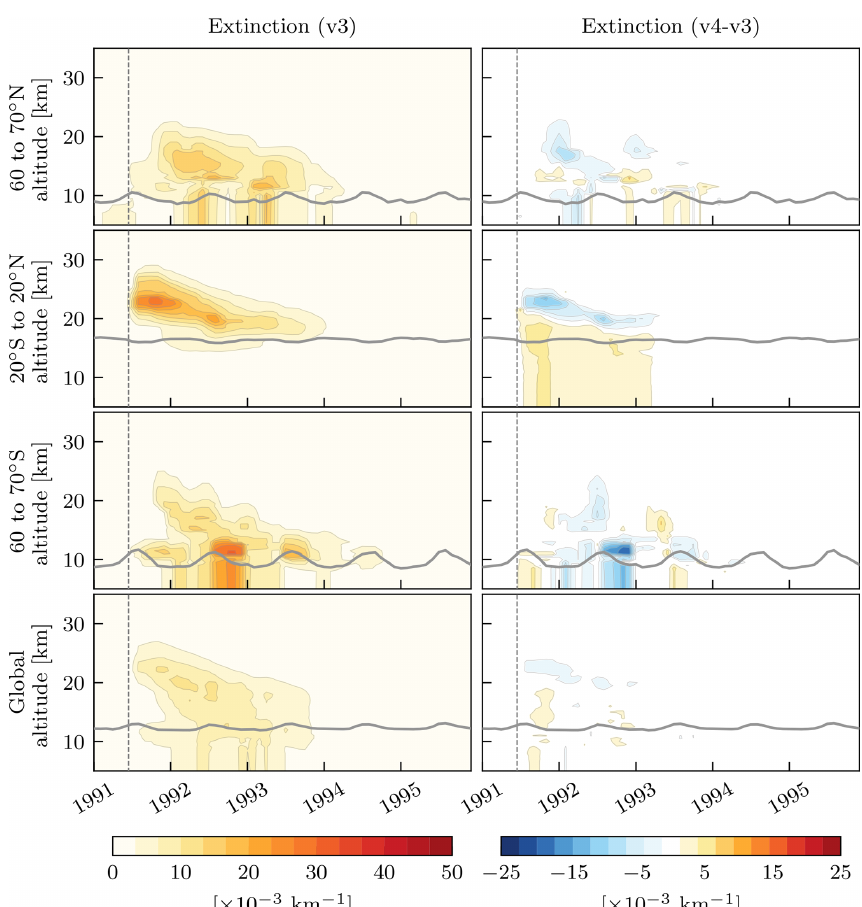
Figure 2. The left column shows the version 3 extinction at 550nm in four latitude bands. The right column shows the change in extinction when the newer version 4 data product is used (v4 − v3). The solid gray lines show the monthly NCEP1 thermal tropopause, and the dashed line indicates the date of the Pinatubo eruption.